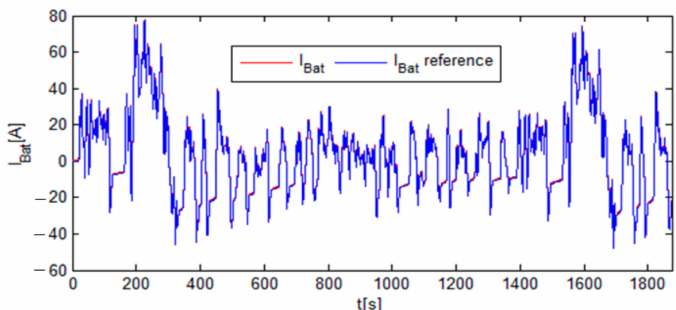
Figure 19. Battery current corresponding to medium frequency